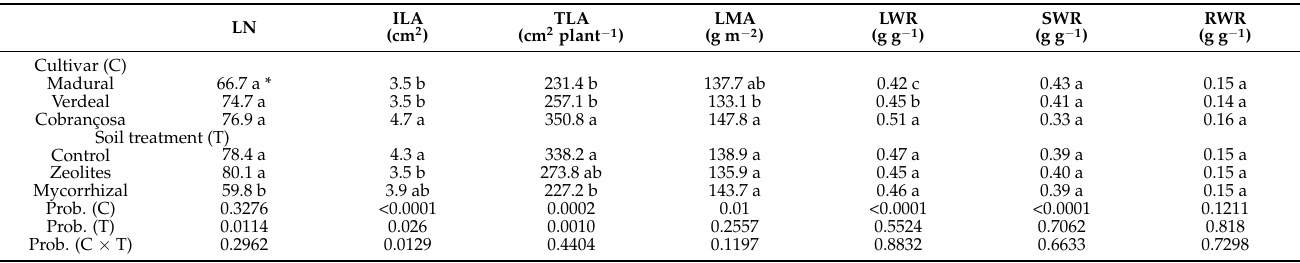
Table 2. Leaf number per plant (LN), individual leaf area (ILA), total leaf area (TLA), leaf mass per area (LMA), leaf weight ratio (LWR), stem weight ratio (SWR), and root weight ratio (RWR) as a function of cultivar and soil